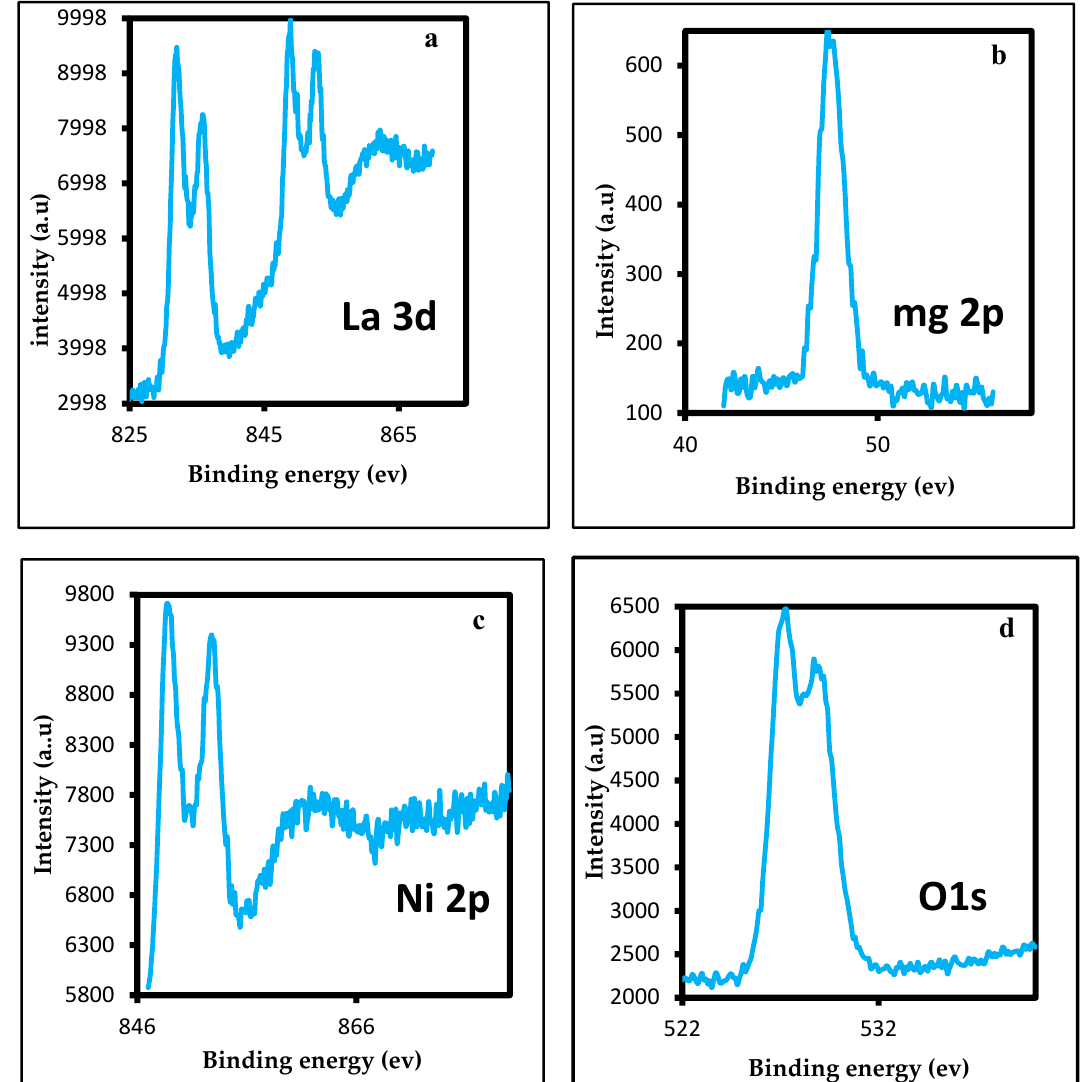
Figure 3. XPS narrow scans of the reduced catalyst: ( a ) La3d ( b ) Mg2p, ( c ) Ni2p, and ( d ) O1s.